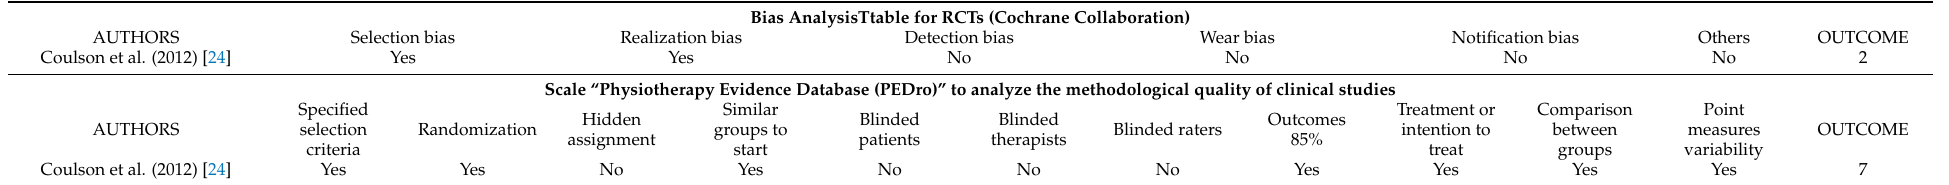
Table 2. Methodological quality evaluation of the clinical trials using the PEDro scale and the Cochrane risk of bias tool for assessing the risk of bias in randomized trials.